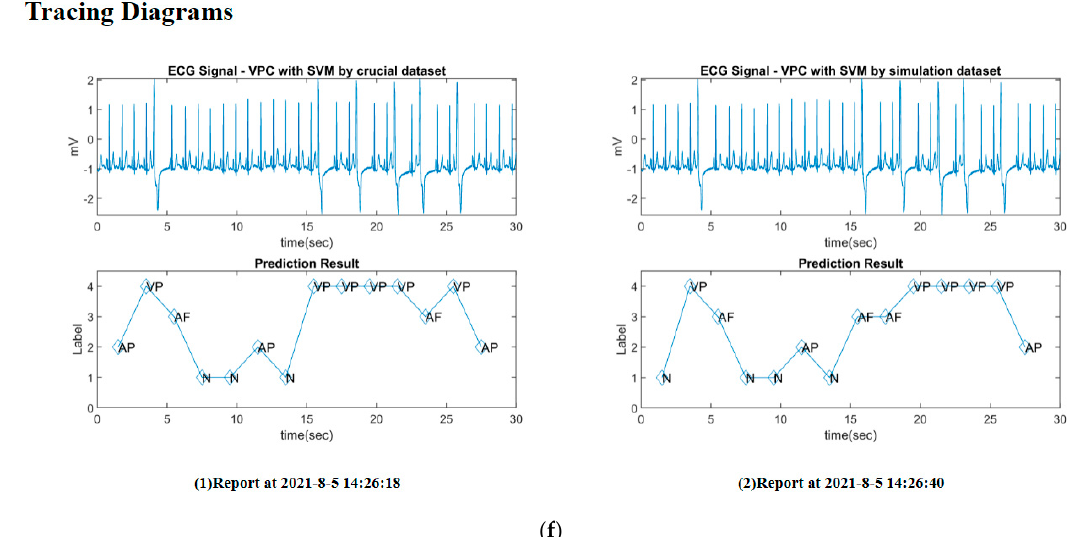
Figure 8. The screen snapshots for recognizing and managing arrhythmia data on the web-based ECG4UHM platform: ( a ) input of the HHT processing parameters for feature extraction; ( b ) selection of the machine learning model for arrhythmia pattern recognition; ( c ) display of the recognition results; ( d ) selection of the input ECG data and correspondent feature set to create the trace diagram; ( e ) management of traceable diagram log for review; ( f ) review page of traceable diagrams.